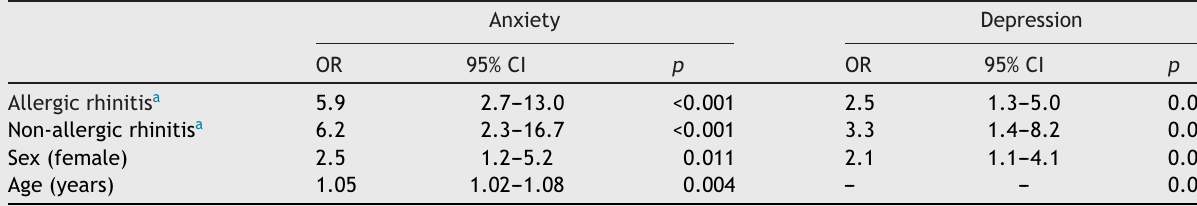
Multivariate model of association for allergic and non-allergic rhinitis with anxiety and